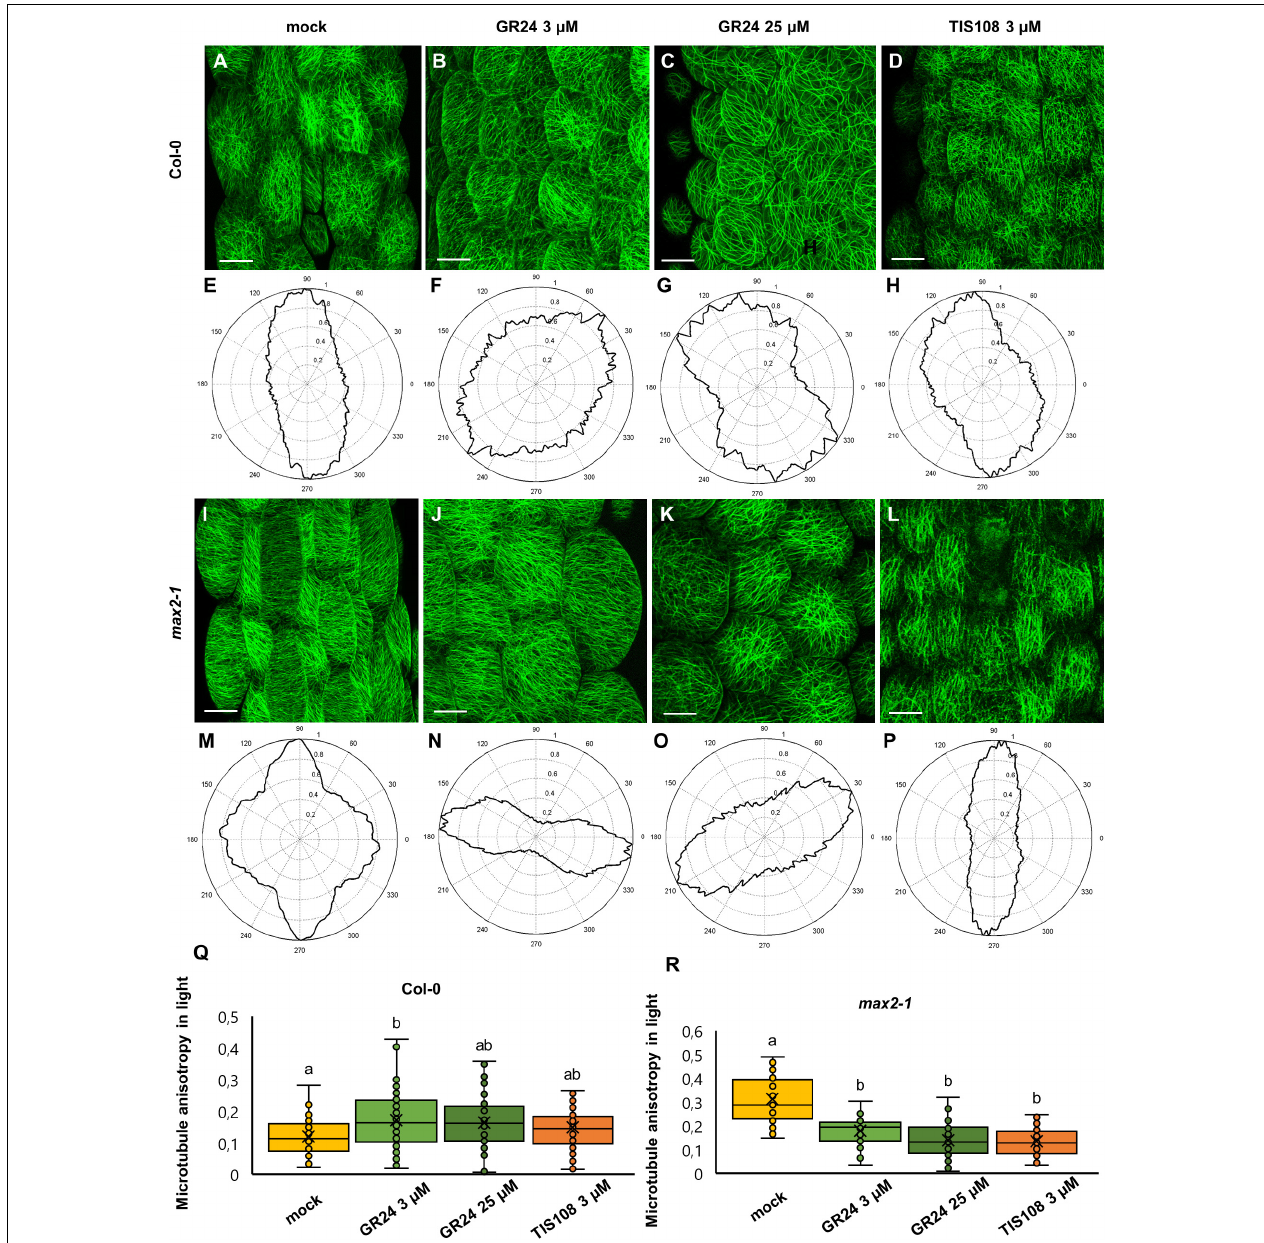
FIGURE 3 | Assessment of microtubule organization in epidermal hypocotyl cells of light-grown seedlings of Arabidopsis Col-0 or the max2-1 mutant expressing GFP-MBD marker in the presence or absence of the synthetic strigolactone GR24 (3 µ M and 25 µ M) or the biosynthetic inhibitor of strigolactone production TIS108 (3 µ M). (A–D) Overview of hypocotyl of Col-0 seedlings treated with mock (A) , 3 µ M GR24 (B) , 25 µ M GR24 (C) , 3 µ M TIS108 (D) . (E–H) Cytospectre graphs of cortical microtubule distribution, where panel (E) corresponds to panel (A) , panel (F) to panel (B) , panel (G) to panel (C) , and panel (H) to panel (D) . (I–L) Overview of hypocotyl of max2-1 seedlings treated with mock (I) ; 3 µ M GR24 (J) , 25 µ M GR24 (K) , 3 µ M TIS108 (L) . (M–P) Cytospectre graphs of cortical microtubule distribution, where panel (M) corresponds to panel (I) , panel (N) to panel (J) , panel (O) to panel (K) , and panel (P) to panel (L) . (Q) Quantitative assessment of anisotropy of cortical microtubule organization in etiolated Col-0 after mock treatment and treatments with 3 µ M GR24, 25 µ M GR24, and 3 µ M TIS108 ( N ≥ 54; Welch’s ANOVA was followed with Scheffé’s test; a statistical comparison is shown within groups sharing the same genotype; letters in the graph are shared by groups without statistically significant differences at the 0.01 probability level; results are in Supplementary Table 4 ). (R) Quantitative assessment of anisotropy of cortical microtubule organization in etiolated max2-1 after mock treatment and treatments with 3 µ M GR24, 25 µ M GR24, and 3 µ M TIS108 ( N ≥ 31; Welch’s ANOVA was followed with Scheffé’s test; a statistical comparison is shown within groups sharing the same genotype; letters in the graph are shared by groups without statistically significant differences at the 0.01 probability level; results are in Supplementary Table 5 ). In all box plots, the average is presented by × , median by the middle line, 1 st quartile by the bottom line, 3 rd quartile by the top line; the whiskers lie within the 1.5 × interquartile range (defined from the 1 st to the 3 rd quartiles) while outliers are omitted. Scale bars: 20 µ m.